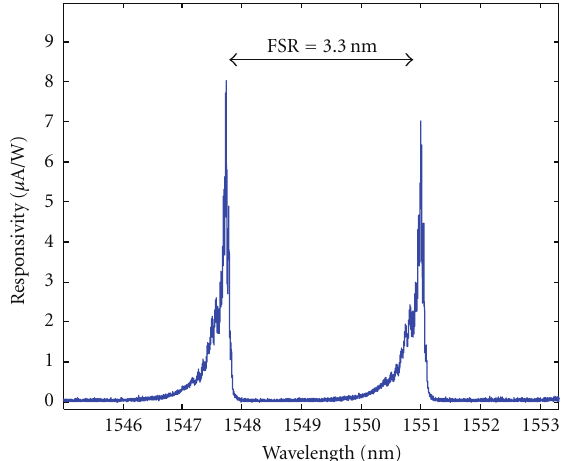
Figure 4: Measured external responsivity versus wavelength for the proposed Cu/p-Si photodetector at − 100